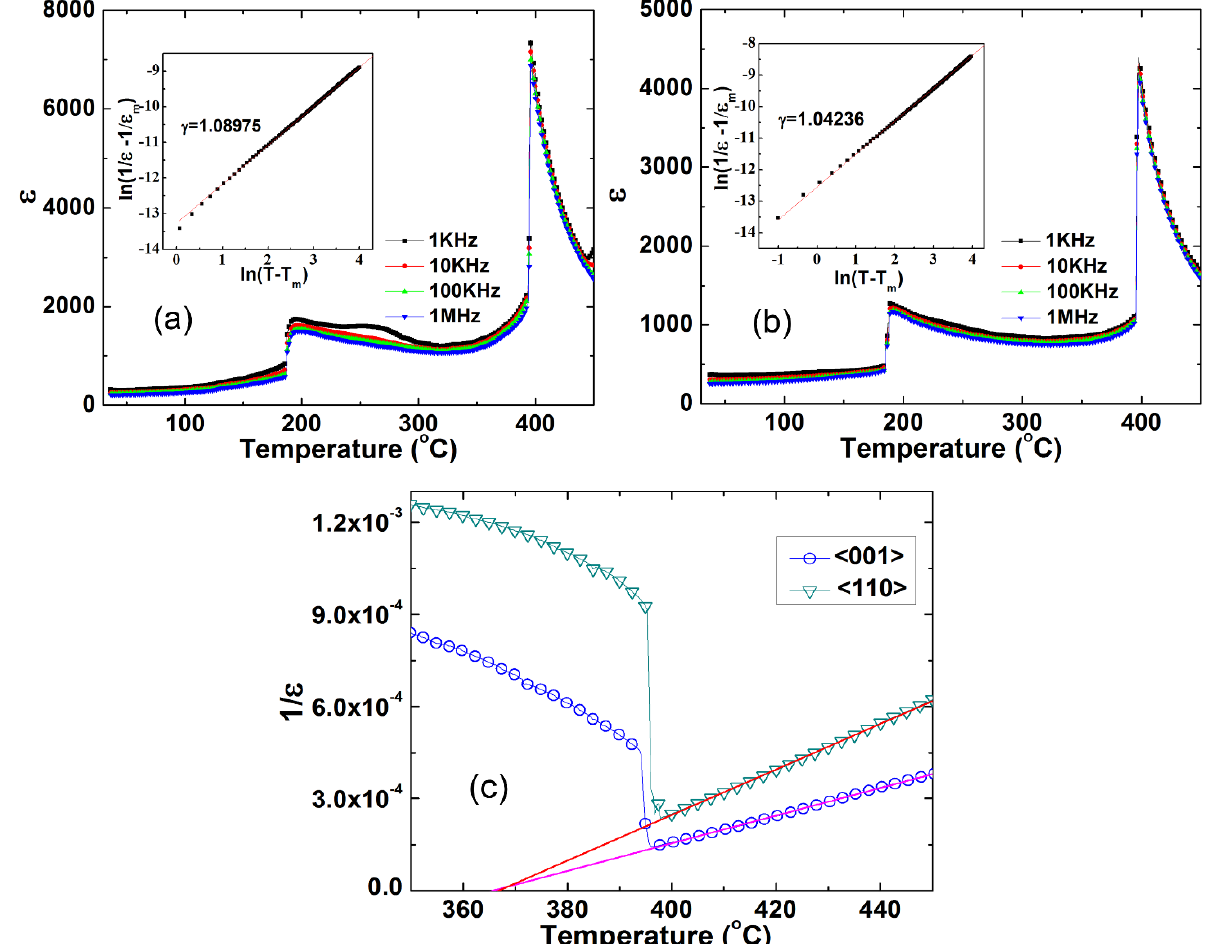
Figure 11. Temperature dependence of the dielectric constants of ( a ) (100) pc and ( b ) (110) pc oriented KNN25/75 crystals at different frequencies. The insets show their respective ln(1/ ε − 1/ ε m ) vs. ln( T − T m ) curves; ( c ) 1/ ε vs. T curves of (100) pc and (110) pc oriented KNN25/75 crystals. Reprinted with permission from [28]. Copyright 2014 Royal Society of